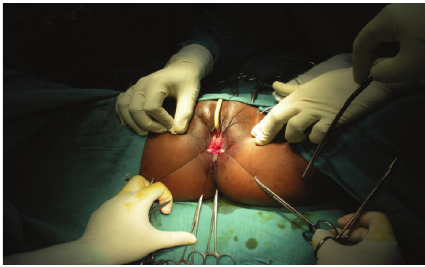
Figure 2: Exposure of operative area.